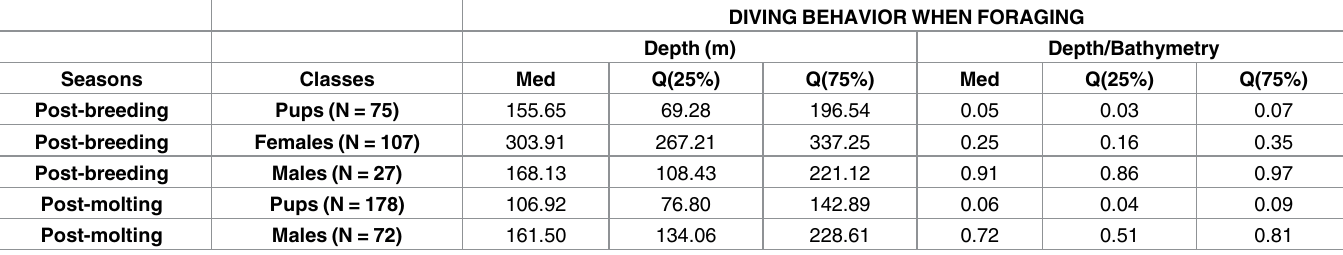
Table 5. Hooded seal diving behavior when foraging for adult males, adult females and pups during the post-breeding and the post-molting sea- sons. Med. = median,and Q(25%) and Q(75%) = the 25% and 75% quantiles, respectively. The numberof days per age/sex class and season is detailedin parentheses. These records represent diving activities conductedby 2 males, 6 females and 5 pups in the post-breedingperiodand by 2 males and 5 pups in the post-molting